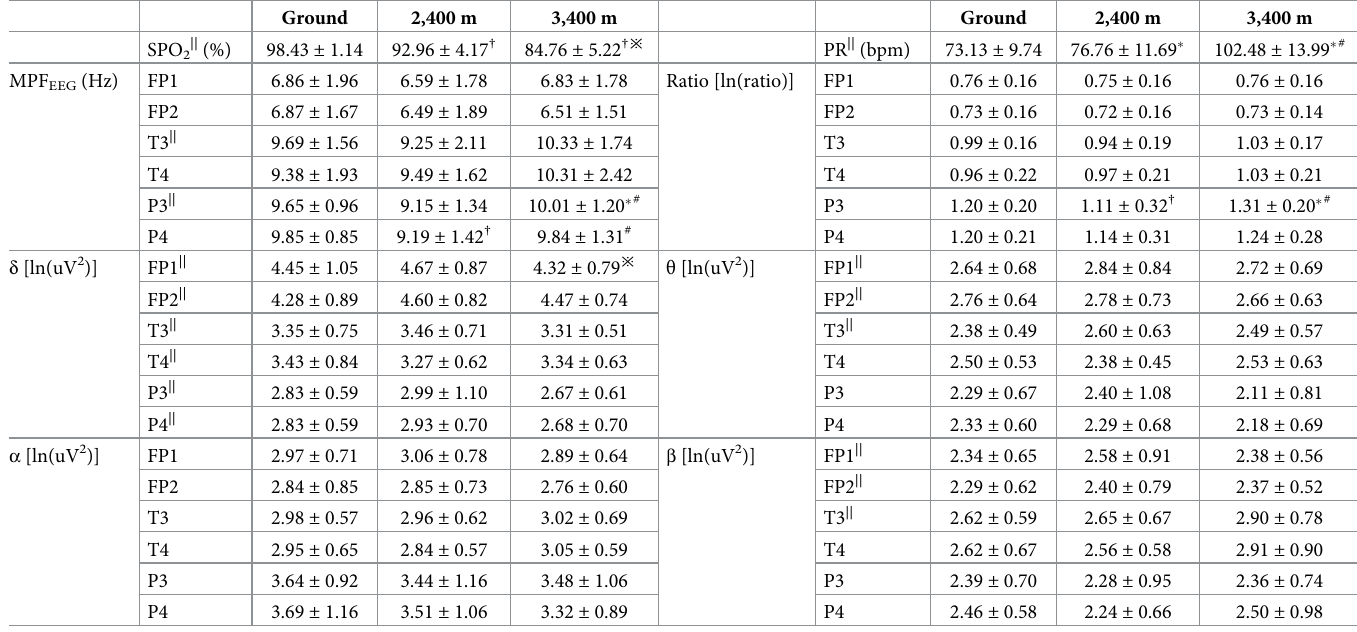
Table 2. SpO 2, PR, and EEG parameters comparison between different altitudes at ground, 2,400 m, and 3,400